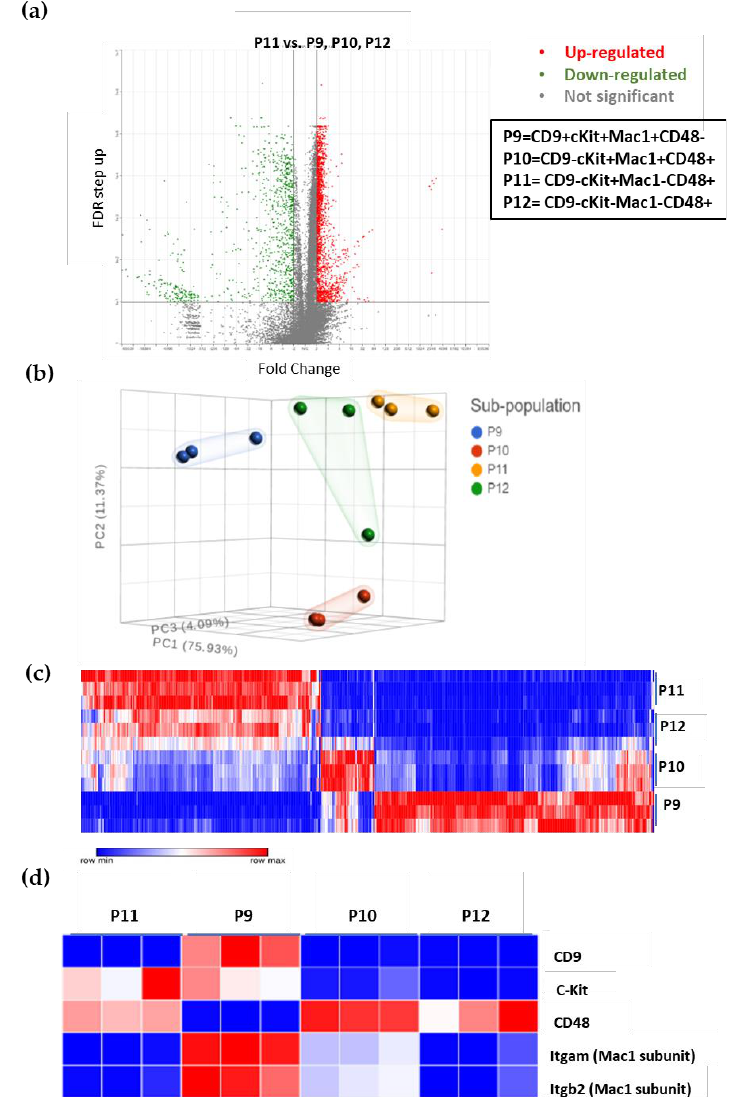
Figure 5. LSCs presenting a unique gene expression signature: ( a ) Some 470 genes (out of 20,020) are differentially expressed between the LSC sub-population (P11) and the other populations (FDR <0.1, fold change >2 or < − 2). ( b ) PCA showing the 4 sub-populations (P9—P12). ( c ) Heatmap showing the 470 differentially expressed genes. ( d ) RNA expression signature of the four surface markers was found close to its expression at the protein level and used for validation (compare with Figure 3).